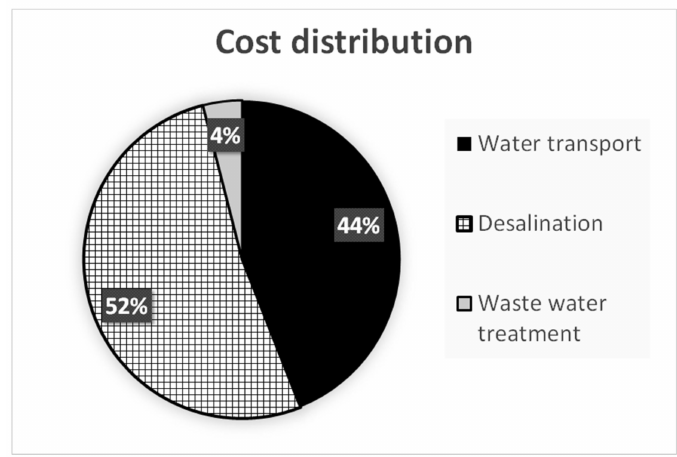
Figure 7. Cost distribution of the proposed water network on